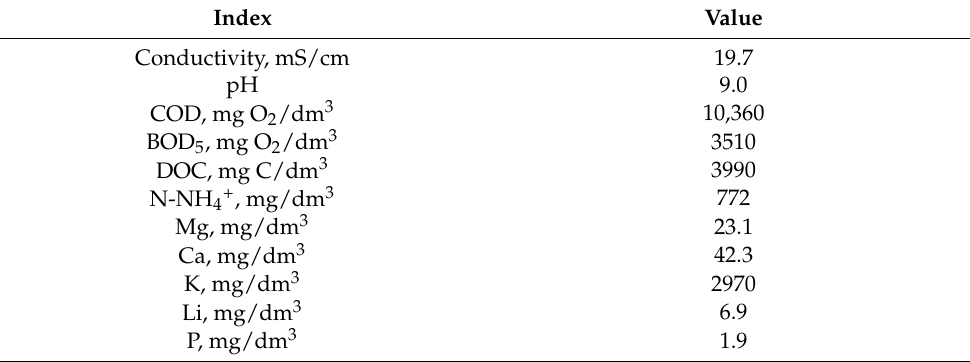
Table 3. Properties of the liquid fraction of municipal digestate after struvite